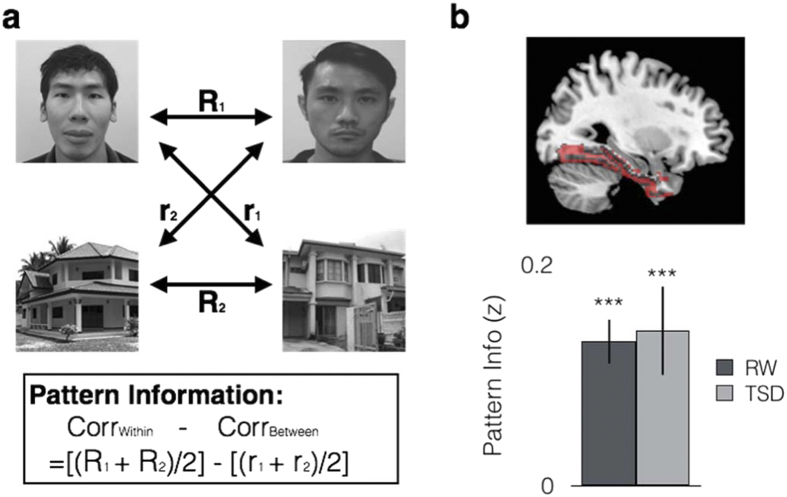
Cross-correlation analysis of pattern information.(a) A ROI was deemed to contain category information when the difference between its within- and between- category correlation was significantly greater than zero (16). (b) Results for cross correlation within the Ventral Visual Cortex (VVC). Pattern information in the VVC was significantly greater than zero in both RW and TSD. Error bars indicate +/−1 SEM. ***p < 0.001.